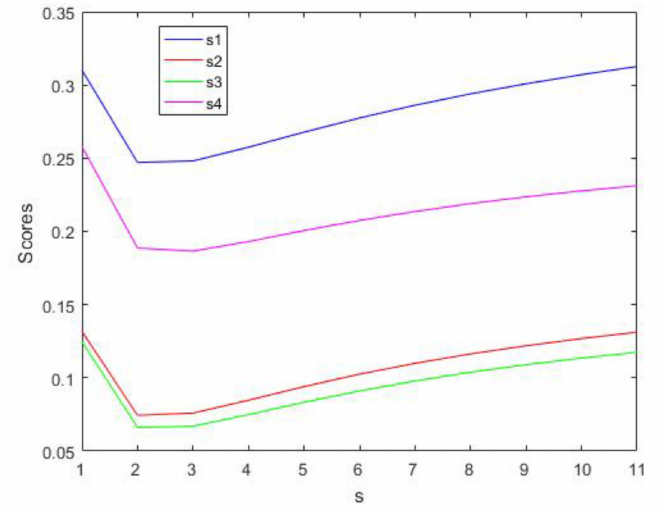
Figure 2. t = 1, s ∈ [ 1,11 ]